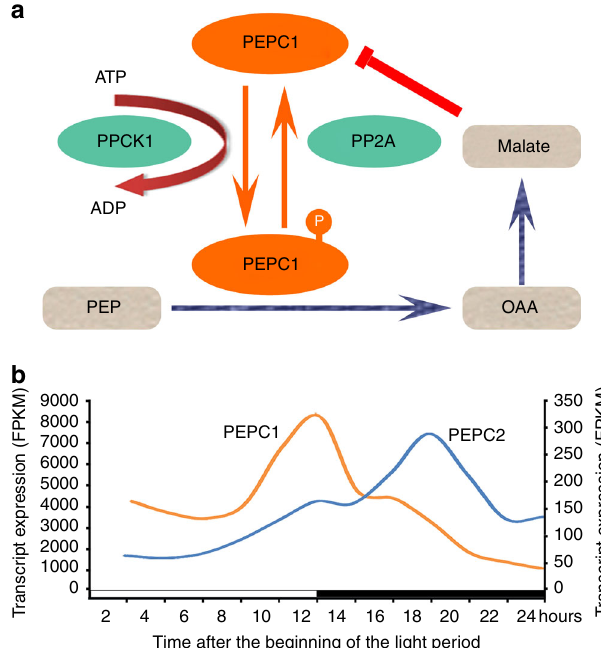
Fig. 5 Two phosphoenolpyruvate carboxylase (PEPC) genes with relative high transcript abundance in Kalanchoë fedtschenkoi . a Regulation of PEPC1 activity. b Diel expression pro fi les of PEPC1 (Kaladp0095s0055.1) and PEPC2 (Kaladp0048s0578.1) transcripts in K. fedtschenkoi , shown in the left and right Y -axis, respectively. OAA Oxaloacetate, PEP phospho enol pyruvate, PEPC PEP carboxylase, PPCK PEPC kinase, PP2A protein phosphatase 2 A. White and black bars indicate daytime (12-h)